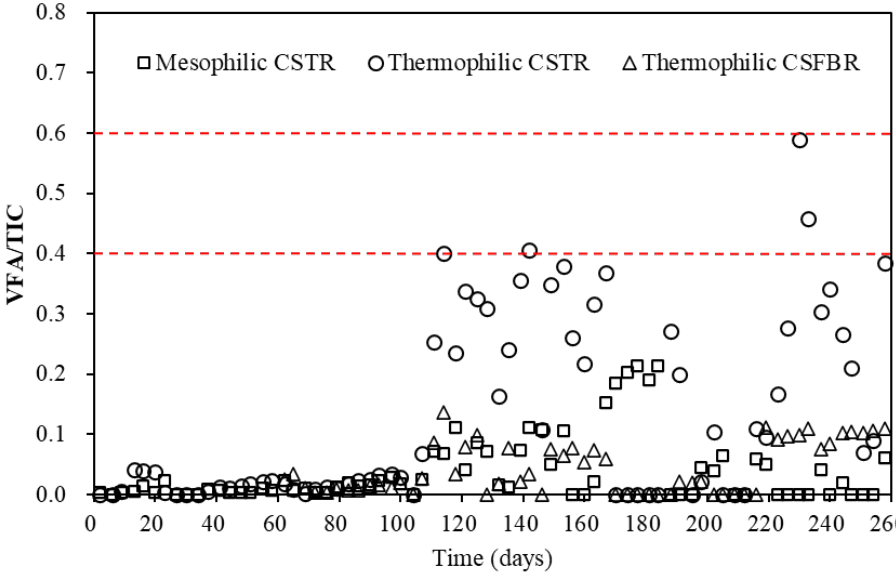
Figure 5. VFA/TIC variations in three anaerobic reactors.